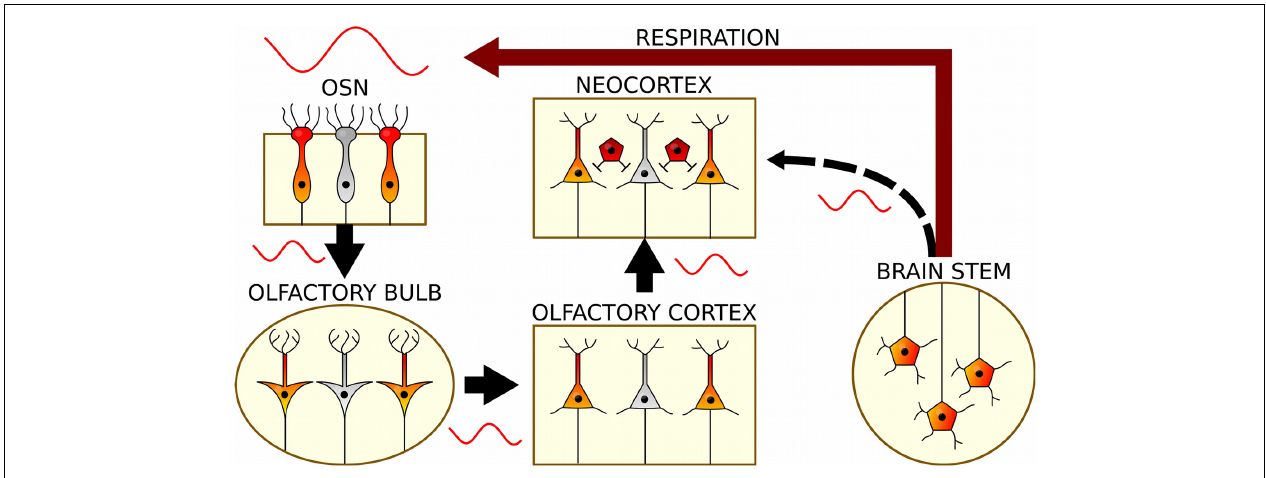
FIGURE 2 | The generation and propagation of respiration-related oscillations in the brain. Rhythmic breathing is generated in the brain stem and feeds back onto neocortical and hippocampal circuits via nasal airflow (red): Air movement through the nasal cavity excites OSNs, which transmit this rhythmic input to mitral and tufted cells of the OB. Via the olfactory cortex, RR reaches the neocortex and subcortical structures. In a presumed corollary discharge pathway, brain stem signals might in addition directly impose RR on cortical circuits